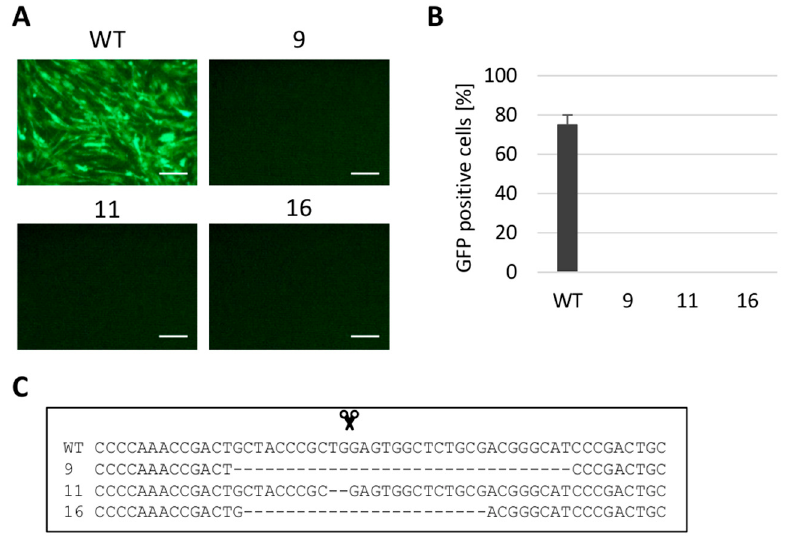
Figure 2. Analysis of ALV-A-resistant clones of DF-1 cells. The selected clones 9, 11, and 16 were challenged with the RCASBP(A)GFP reporter virus. The virus spread in the cell culture was assayed as the presence of GFP-positive cells by fluorescence microscopy ( A ) or FACS ( B ). The homozygous deletion mutations of the tva gene present in these three clones are shown ( C ) with the cleavage point represented by the scissors. The FACS experiment was done in two parallels in two independent experiments and the results are shown as the mean ± standard errors. Scale bar = 100 μ m.